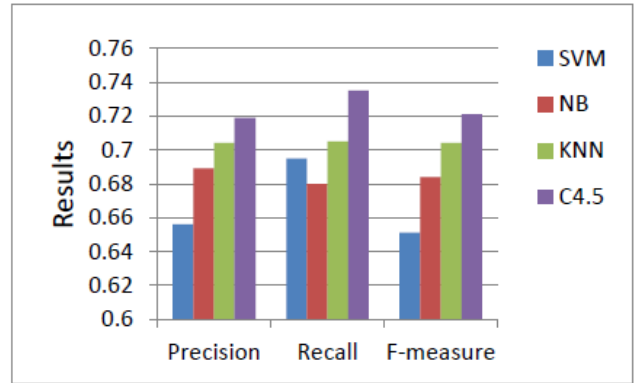
Figure 5. Predictions Results of Various Machine Learning